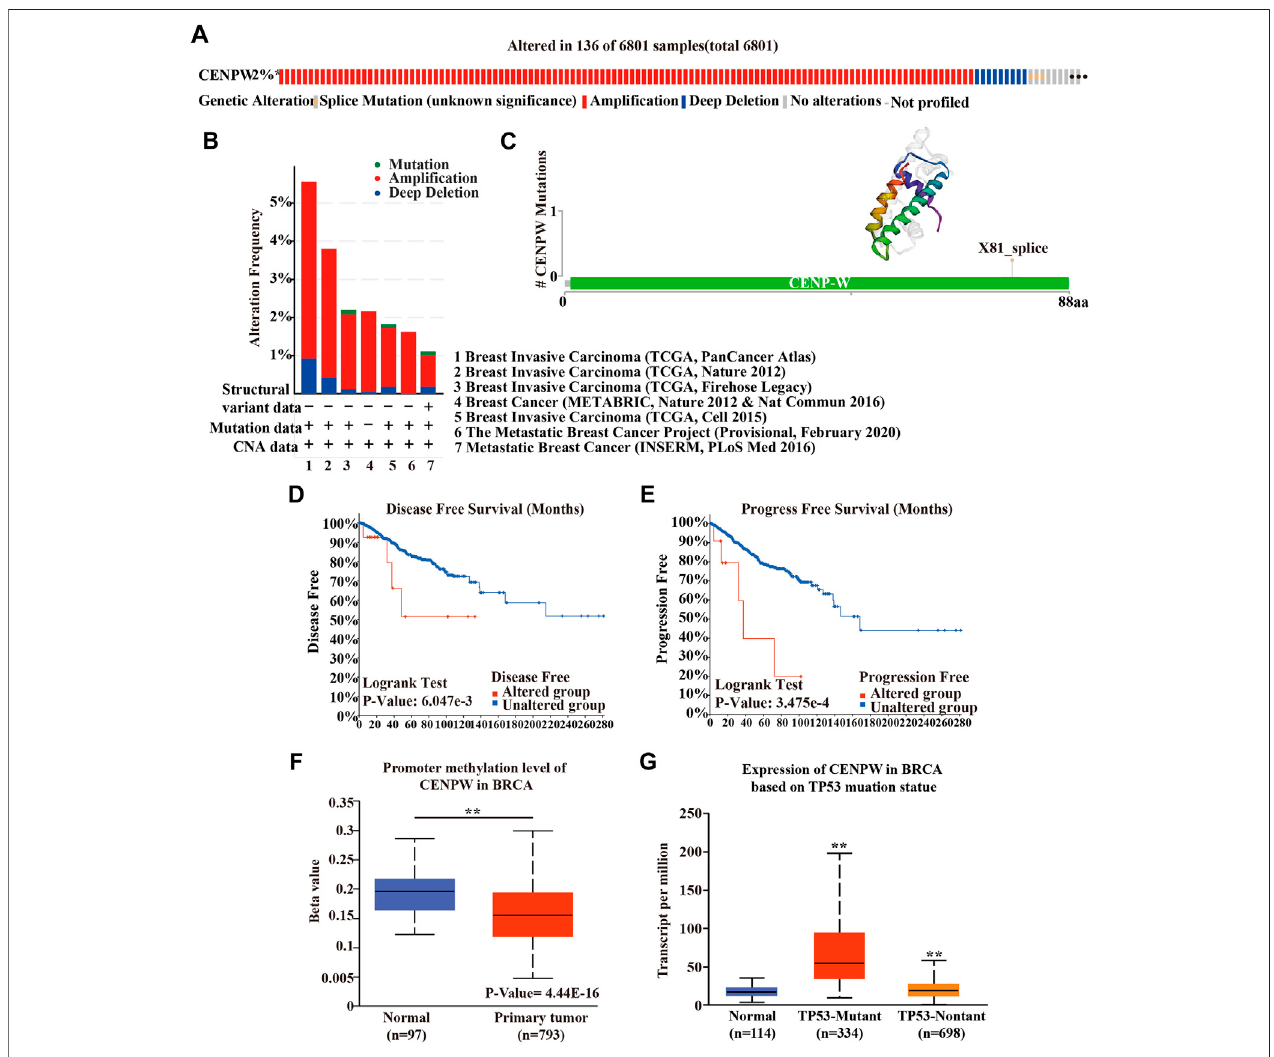
FIGURE 5 | Gene mutation analyses of CENPW . (A) The mutation rate of CENPW in 6,801 samples. (B) Summary of alterations in various expressed CENPW in the cBioPortaldatabase. (C) Themutationsiteand3Dstructureof CENPW .Survivalanalysisof (D) DFSand (E) PFSofthemutated CENPW gene. (F) Thepromotermethylationlevel of CENPW and (G) themRNAexpressionof CENPW basedonTP53mutationstatueinBRCAbyUALCANcancerdatabase.* p < 0.05,** p < 0.01comparedwithcontrolgroup.